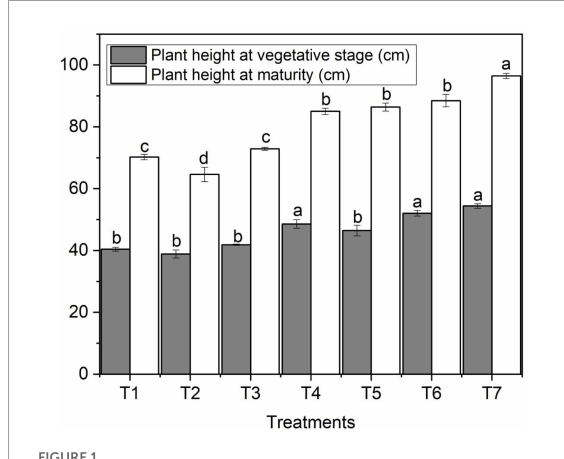
FIGURE1 Effects of different treatments on plant heights under salinity stress. Different letters indicate a significant difference by Duncan’s multiple range tests at p < 0.05. Values are means ± SE ( n = 3). T 1 : without fertilizer application (control),